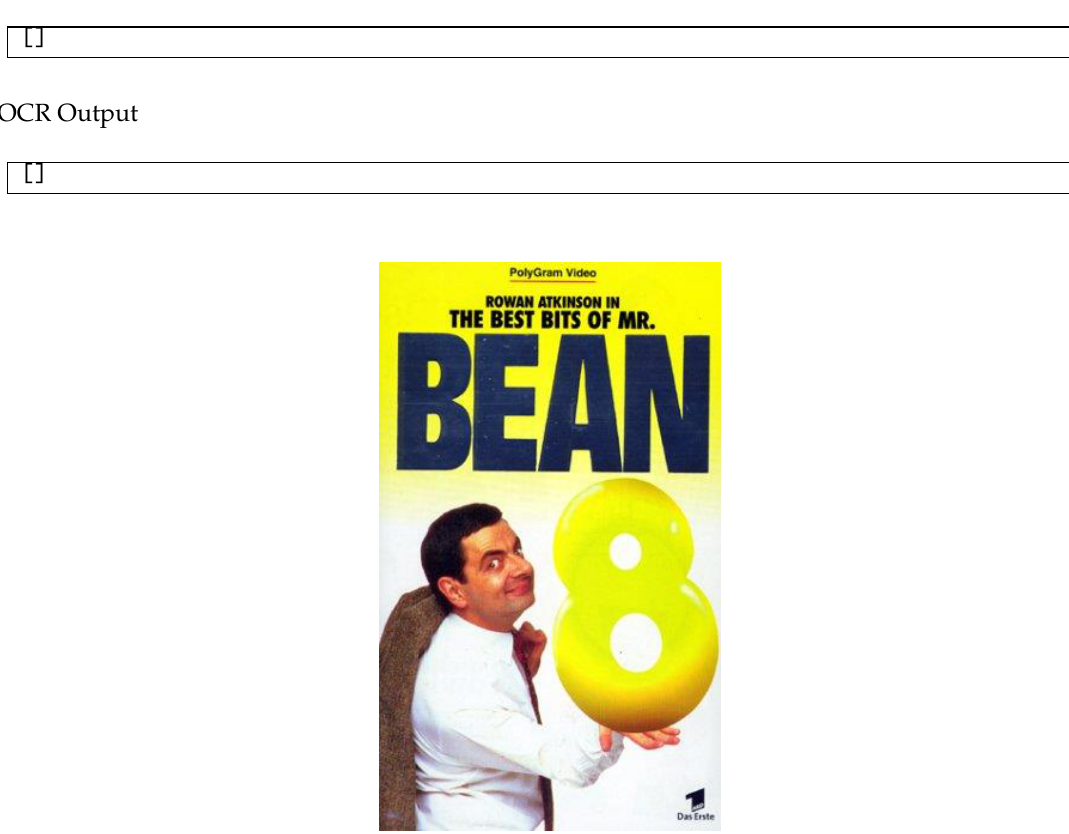
Figure 3. Sample image 3 and related API output.